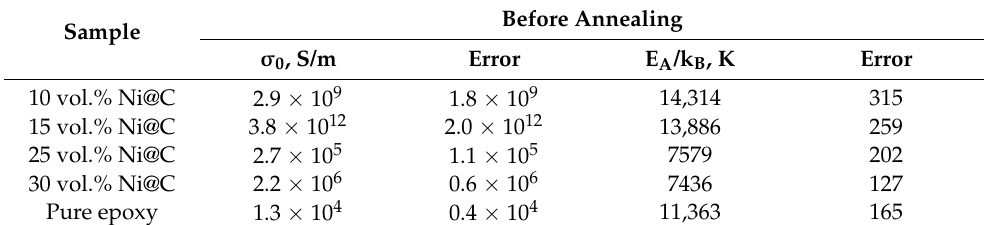
Table 1. Parameters of the Arrhenius law fit for mono-filled Ni@C/epoxy composites.